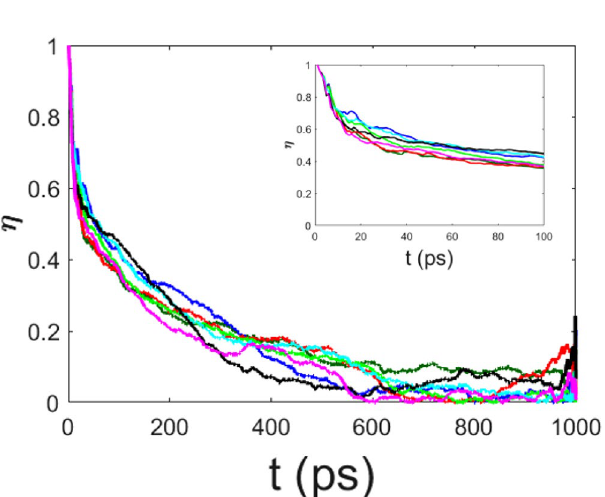
0.1 ( χ 12.2 pN) (dark green), χ Figure 8. The spectral entropy η is plotted vs time for χ ′ = = 1 ( χ 122 pN) (red), χ 2 ( χ 244 pN) (light green), χ pN) (dark blue), χ ′ ′ = = = = 4 ( χ 488 pN) (black), and χ 5 ( χ 610 pN) (purple); the other parameters are the same of blue), χ ′ ′ = = = = 13 Fig. 1. Time t is measured in 10 −